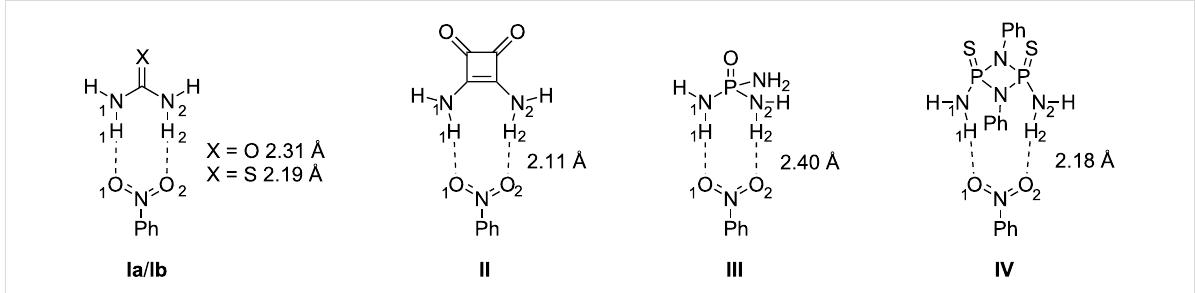
Figure 2: Urea, squaramide, P -triamide and cyclodiphosphazane coordinated to nitrobenzene, with the computed mean H-bond lengths (cf. Table 1).